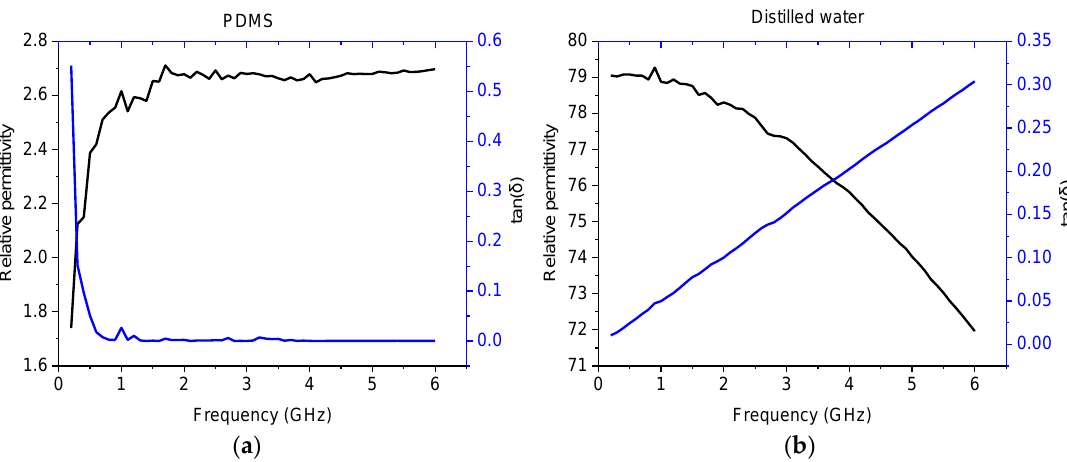
Figure 2. Dielectric properties of the materials measured with Dielectric Assessment Kit (DAK) and used in model: ( a ) polymethylsiloxane (PDMS); ( b ) distilled water.